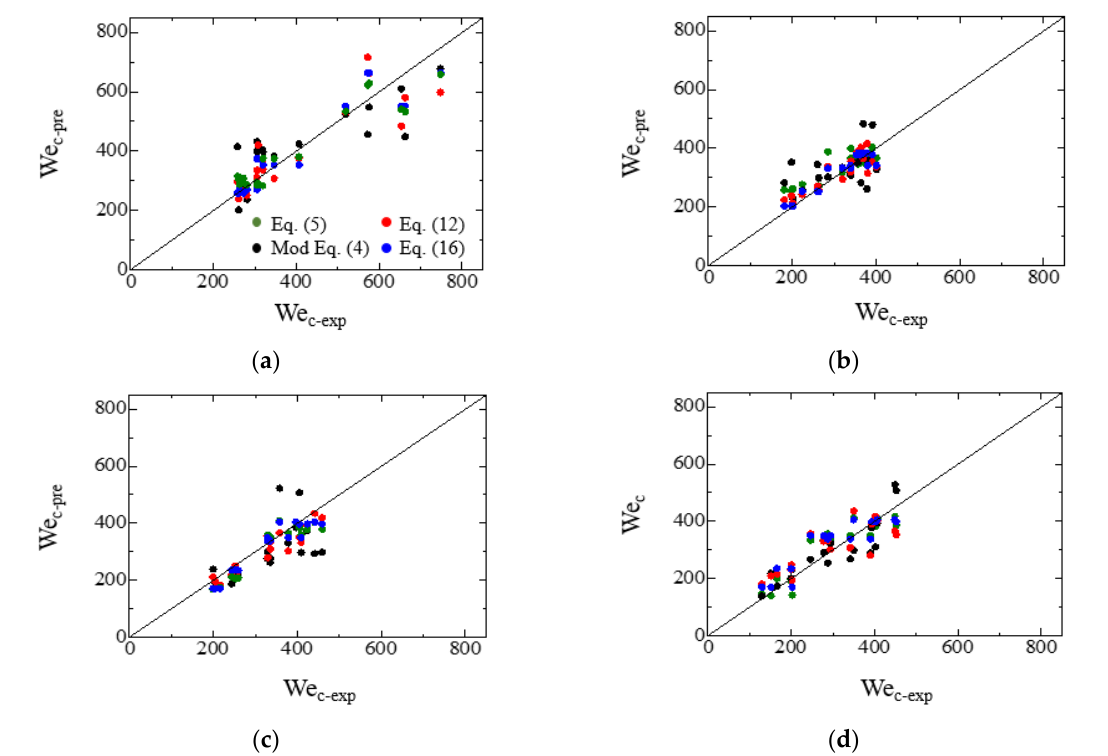
Figure 15. Comparison of experimental value for We c with the predicted one in each model: ( a ) bare substrate; ( b ) #400 substrate; ( c ) #240 substrate; ( d ) #120 substrate. The green, black, red, and blue symbols are predicted by Equation (5), Equation (4) with Equations (10) and (11), and Equation (12) and Equation (16), respectively.